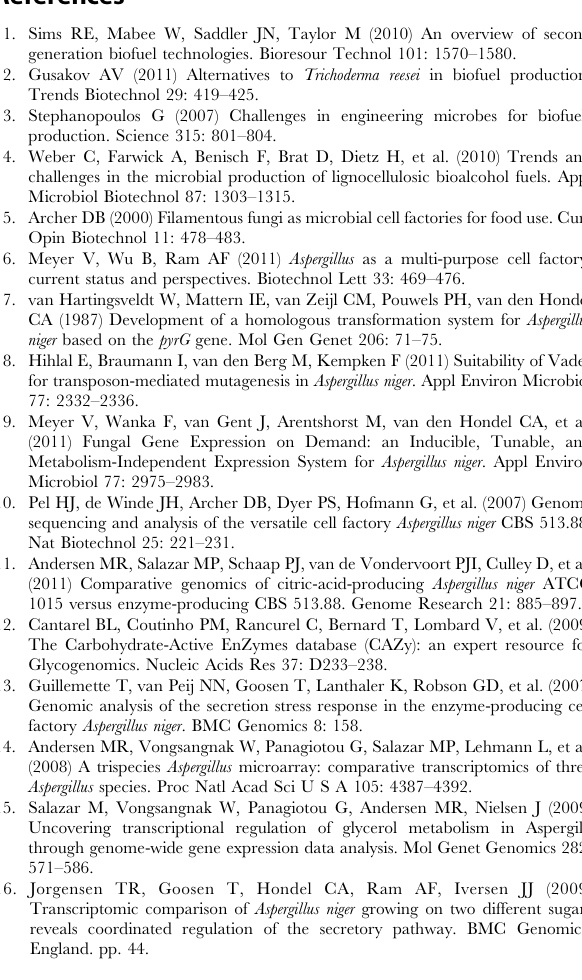
Table S2 Read mapping scores and RPKM values for each biological replicate, the combined mapping scores and statistical significance scores for all genes under Glucose 48 h, Straw 24 h and Straw + Glucose 5 h conditions. Table S3 Inter-sample correlation comparison. R-squared values for comparison of each of the mapping results of each individual biological sample. Table S4 Antisense and sense RPKM values and ratios under Glucose 48 h, Straw 24 h and Straw + Glucose 5 h conditions, for all genes with an antisense RPKM . 1 in any condition. Table S5 Primers used in this